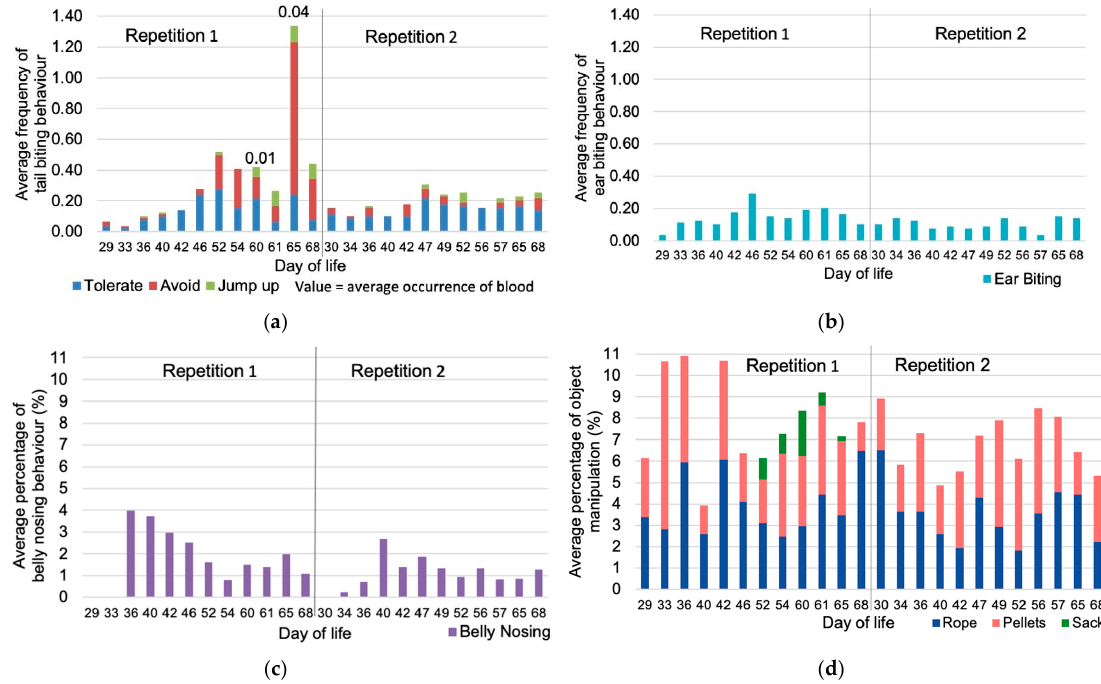
Figure 1. Average frequency and percentage of manipulation behavior per pig and hour by observation day of the rearing period by repetition ( a ) average frequency of tail biting with victims’ reaction per pig; ( b ) average frequency of ear biting per pig; ( c ) belly nosing behavior per pig as percentage of sampling points; ( d ) object manipulation per pig as percentage of sampling points.